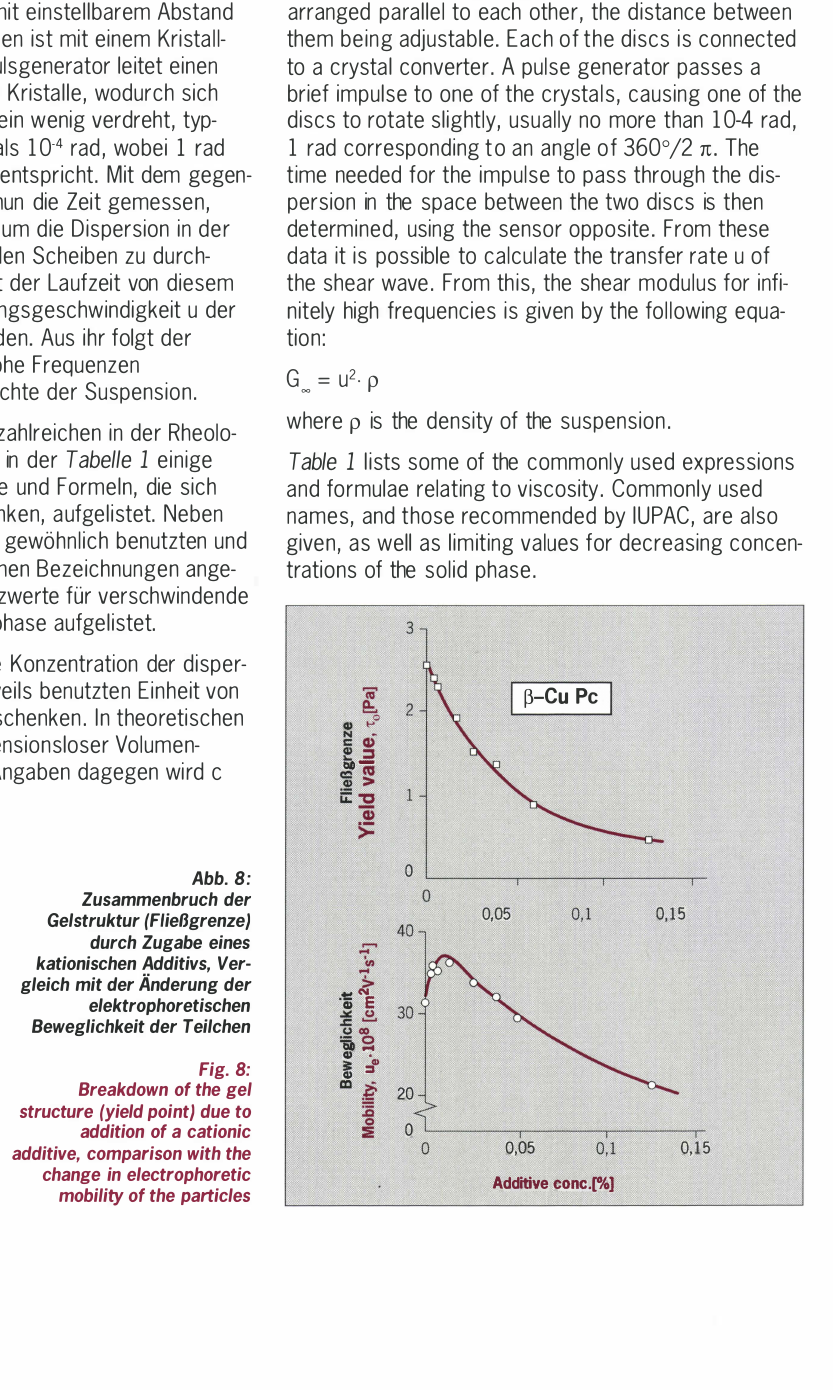
Fig. 8: Breakdown of the